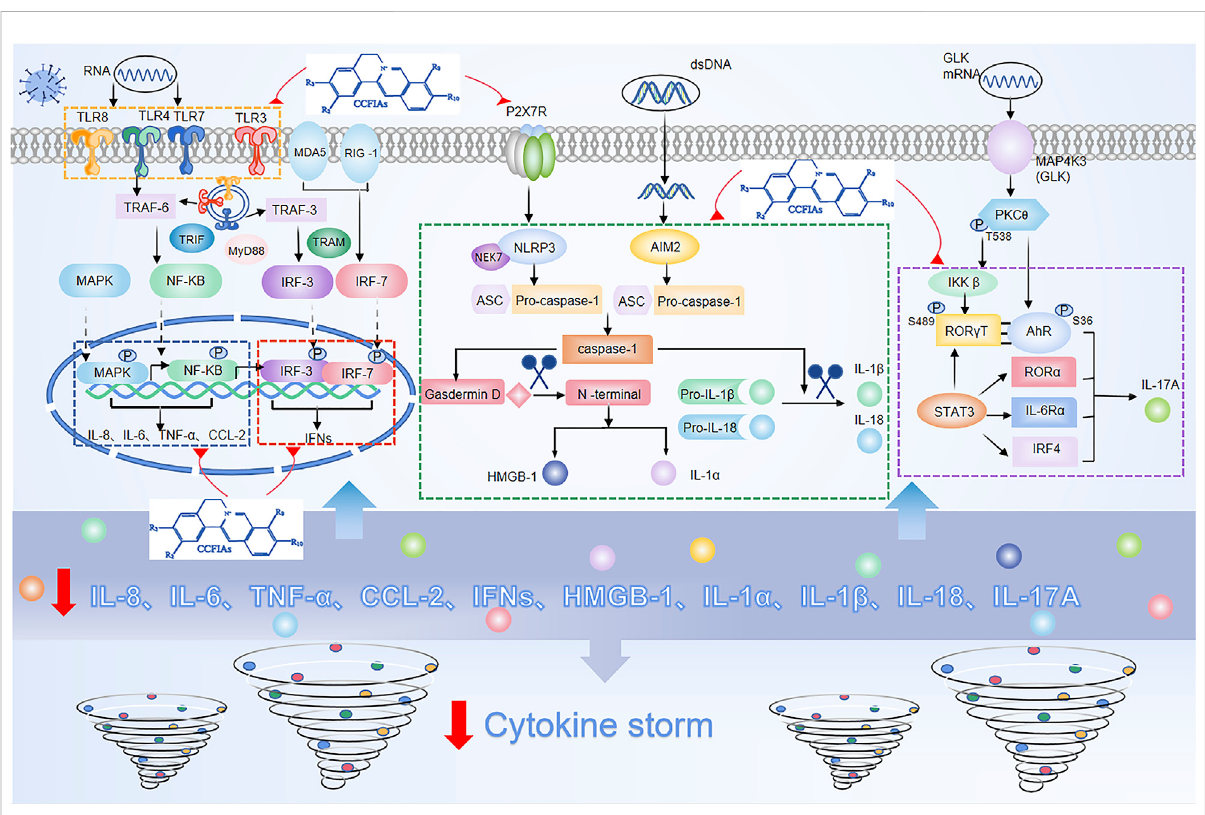
FIGURE 2 Overactivation of innate immune signaling pathways and modulation of these pathways by isoquinoline alkaloids in Coptis Chinensis